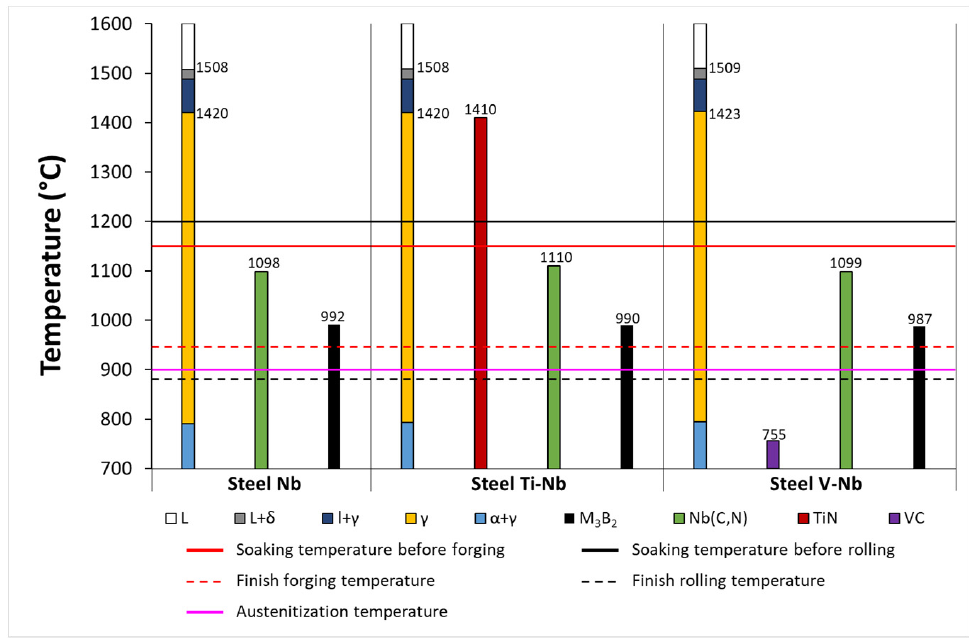
Figure 1. Equilibrium calculations of stability of liquid phase, austenite, ferrite, M 3 B 2 , Nb(C,N), TiN, and VC for all three samples. Temperature regions for hot forging, hot rolling, and austenitization are presented.